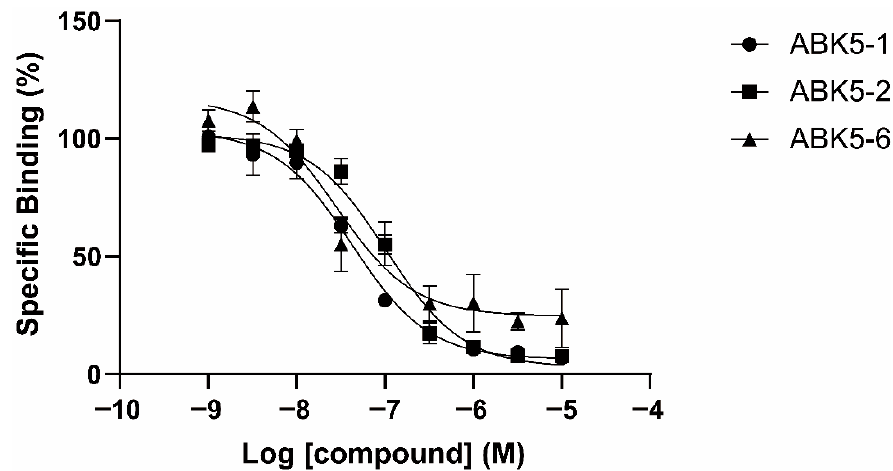
Figure 2. Specific binding of [ 3 H]CP55,940 in the presence of increasing concentrations of ABK5-1 (circles), ABK5-2 (squares), ABK5-6 (triangles). Data are depicted as the mean ± S.D. of three inde- pendent experiments with each carried out in duplicate.